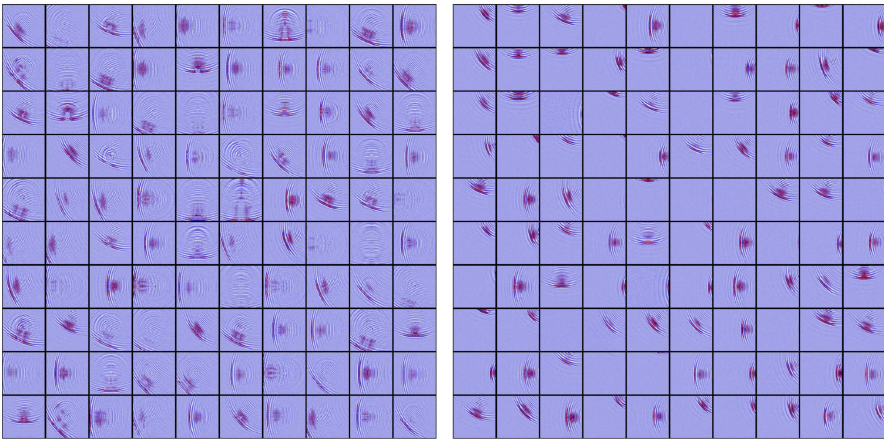
Figure 7. Sample patches from the dataset, including the ones with defects ( left ) and no defects ( right ).